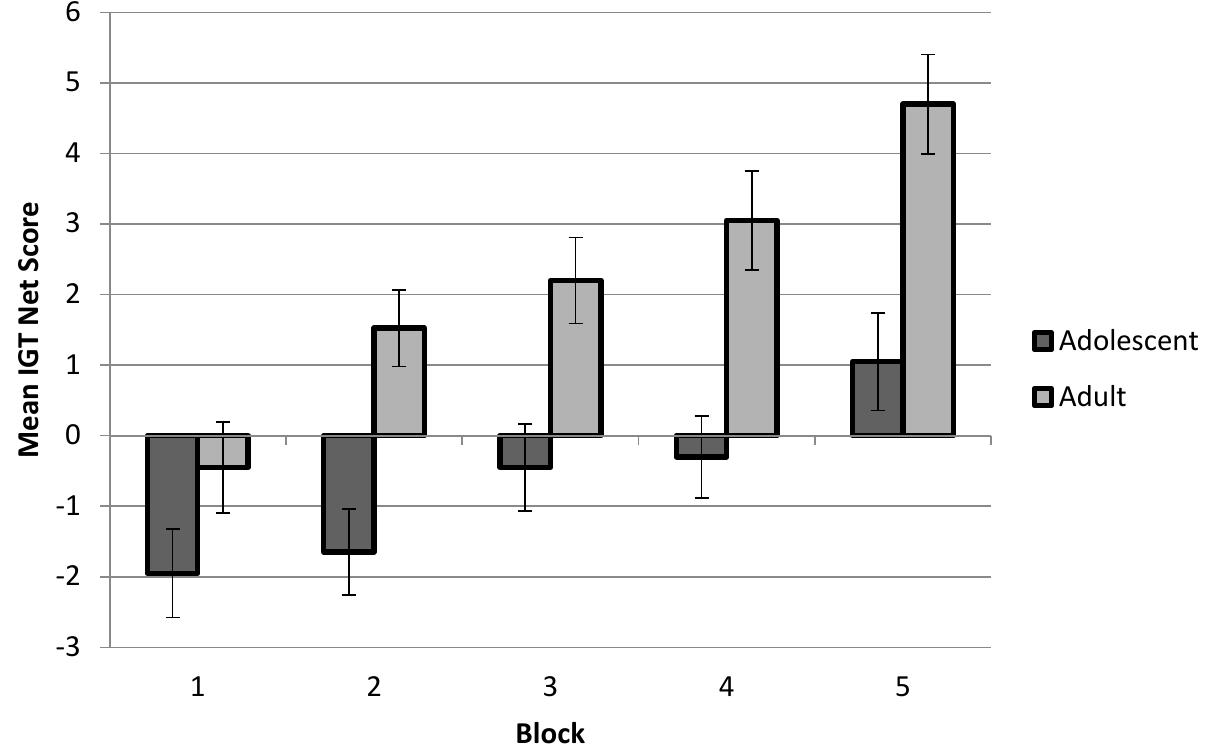
Figure 1. Mean IGT net scores by blocks. Note: mean ( ± SE) IGT net scores of adolescents and young adults by blocks.